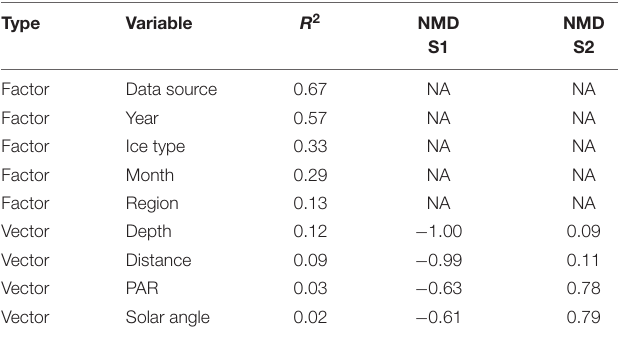
independently observed in the central Arctic (I. A. Melnikov